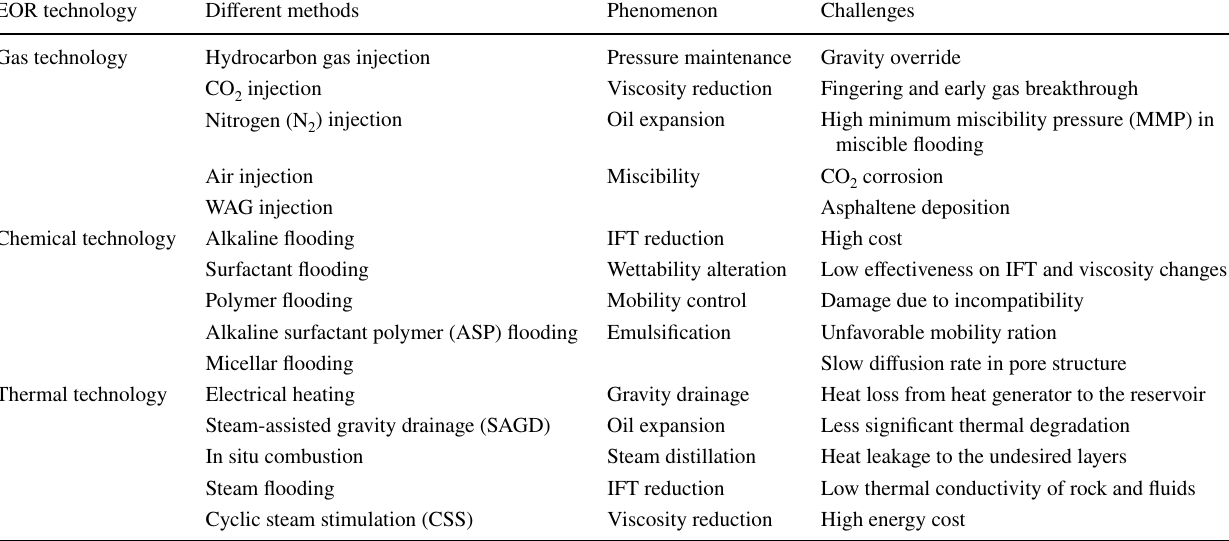
Table 1 Different EOR technologies with different phenomenon and challenges EOR